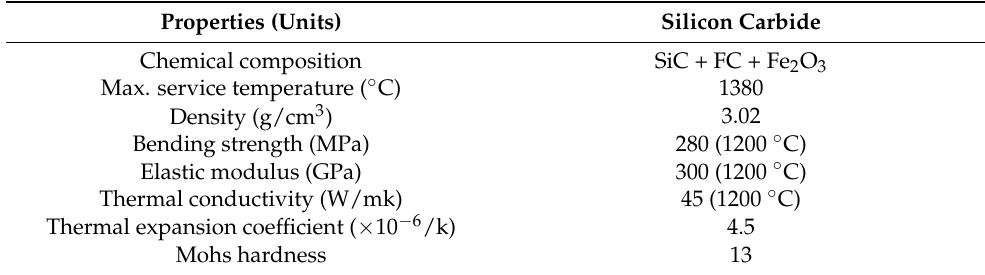
Table 4. Properties of silicon carbide